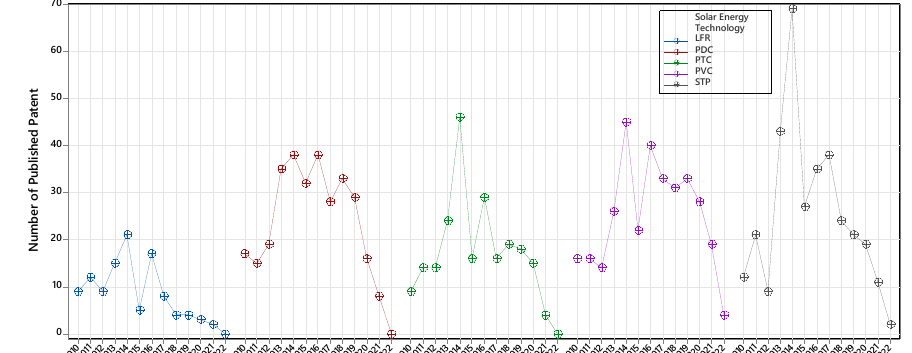
Figure 8. Patent publication pattern from January 2010 to May